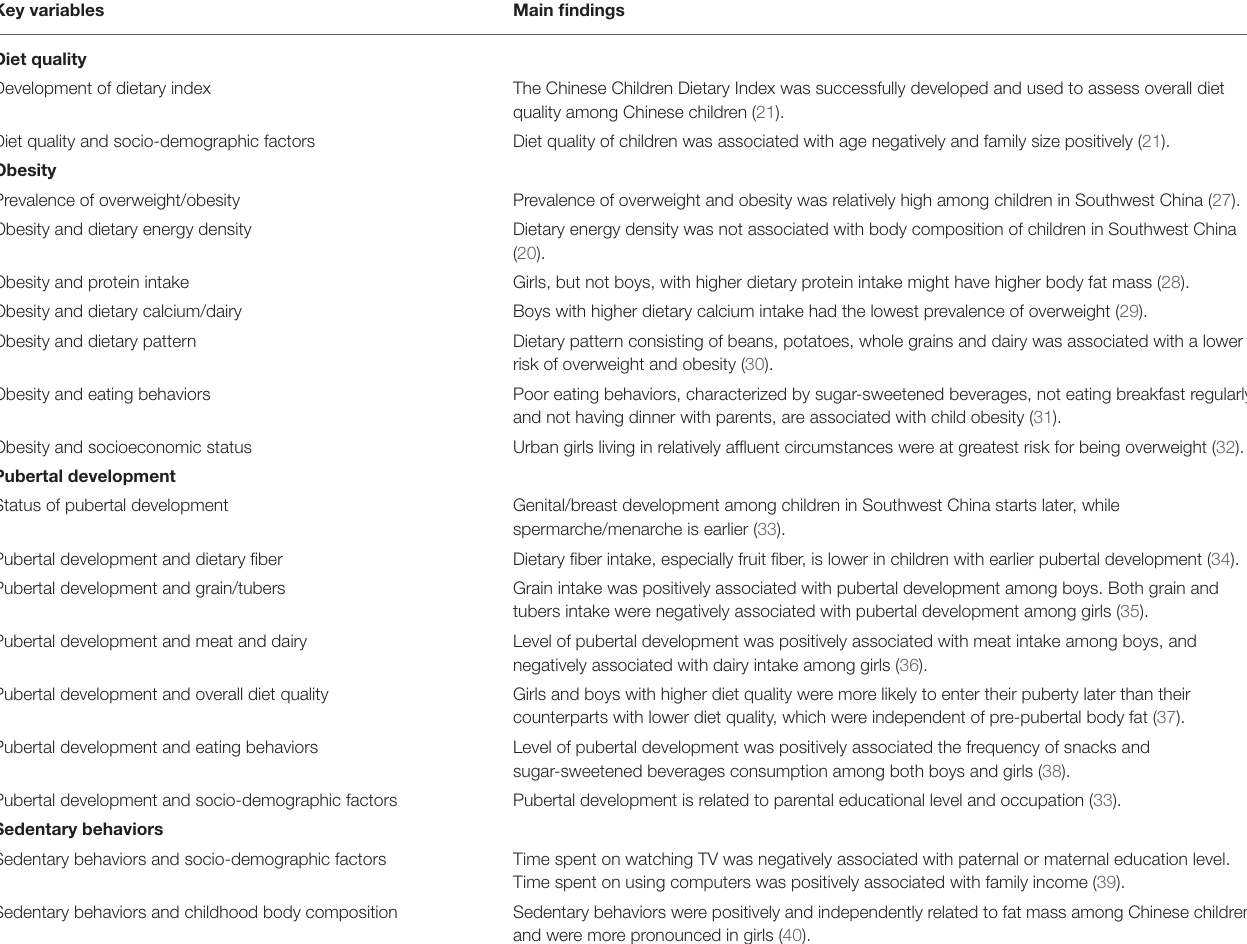
TABLE 4 | Key published findings from the baseline and the first follow-up data of Chinese Adolescent Cohort (CAC) study. Key variables Main